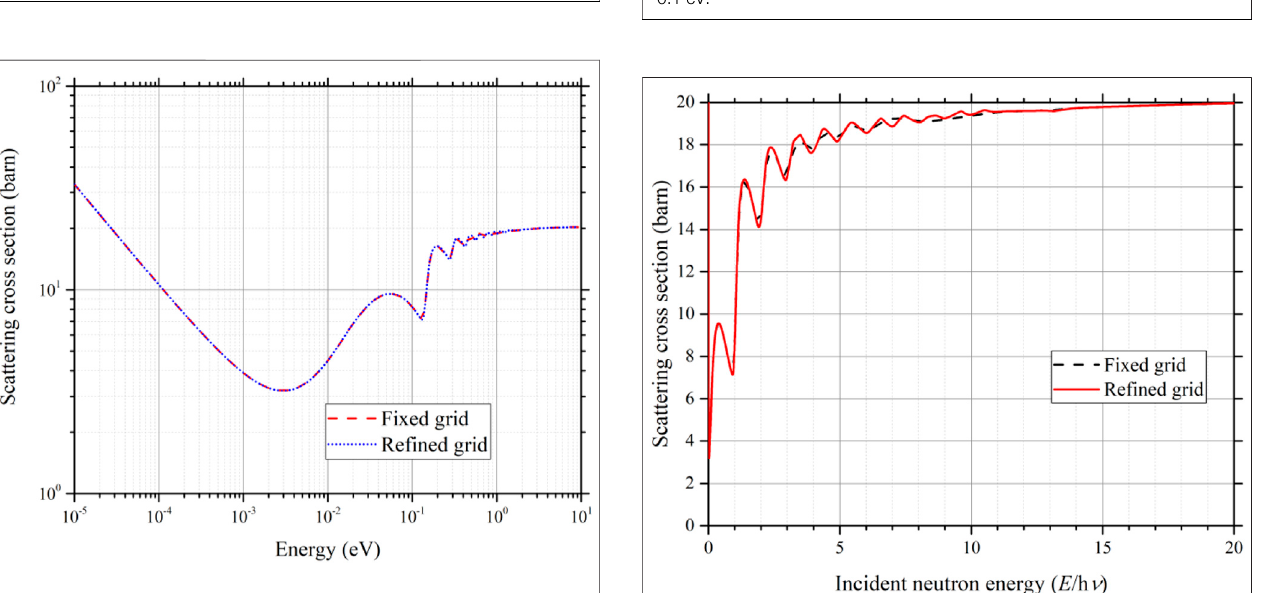
FIGURE 4 | Elastic scattering cross sections of LiH.